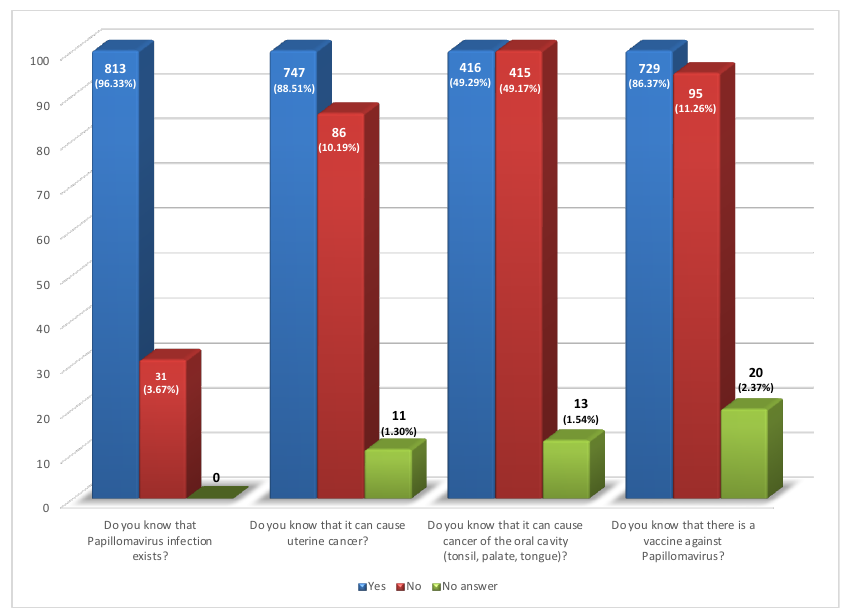
Figure 1. Answers of respondents to the items: #4 Do you know that papillomavirus infection